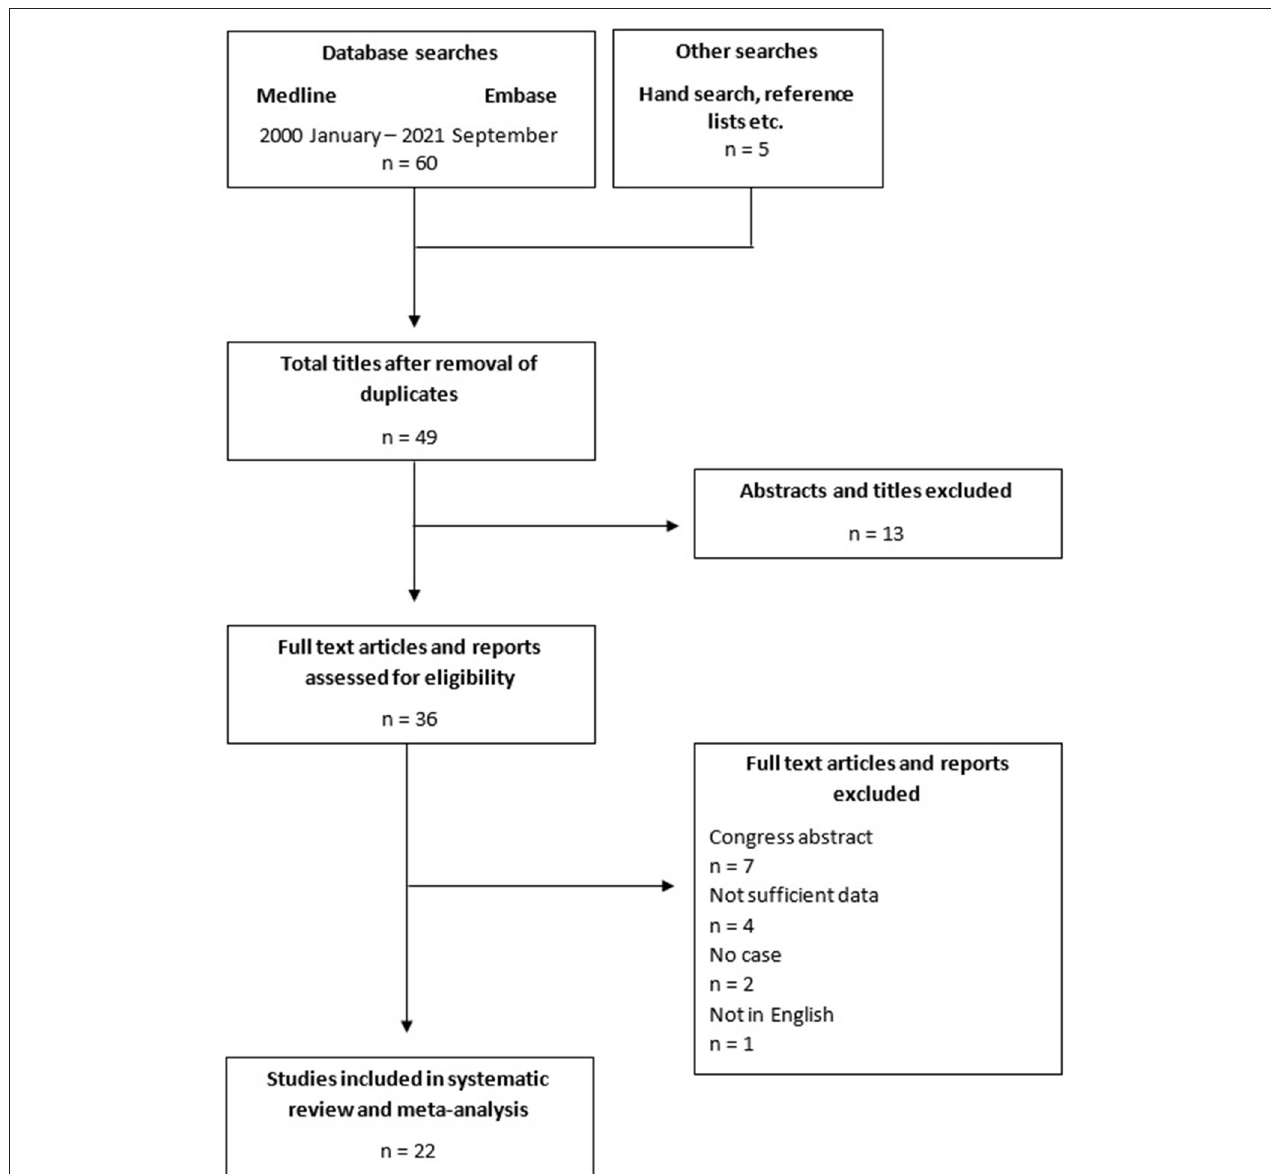
FIGURE 1 | PRISMA